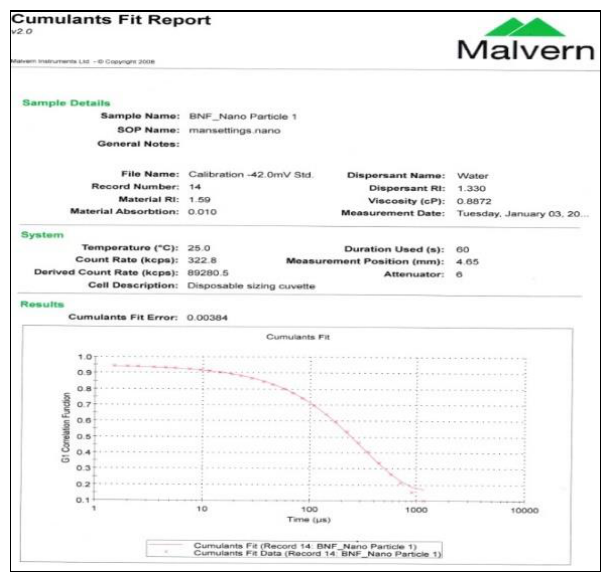
Figure A5. Size distribution report.